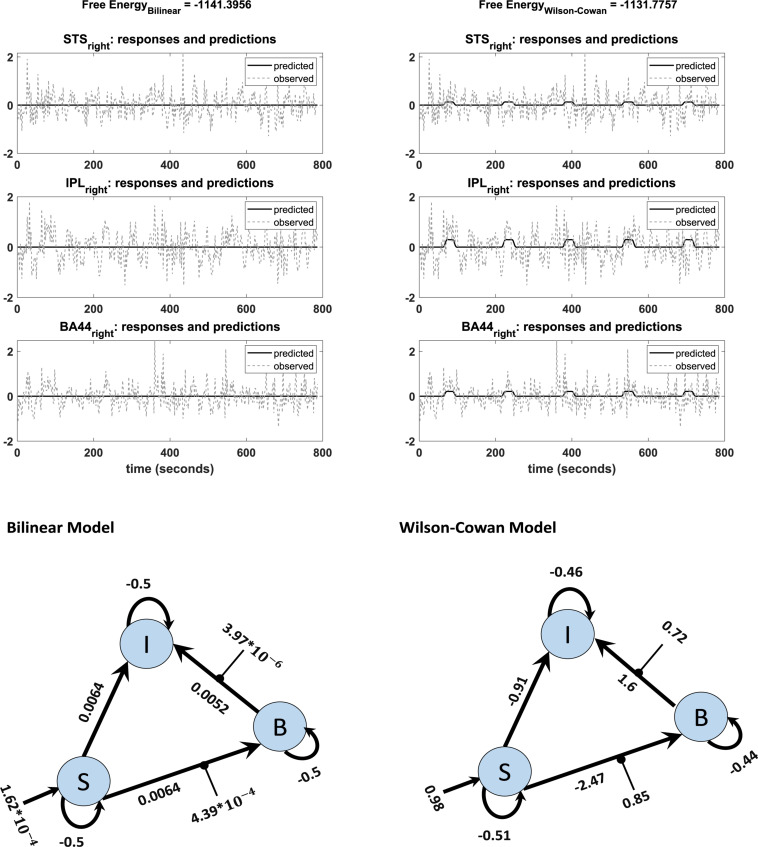
Observed and predicted time-series in DCM analysis of bilinear (left) and W-C (right) models for one subject. The left graph shows a flat time series, while in the right graph, predicted activity reacts to the inputs. The network structures with estimated parameters (the mean of expected values) of each model are illustrated below of each graph.